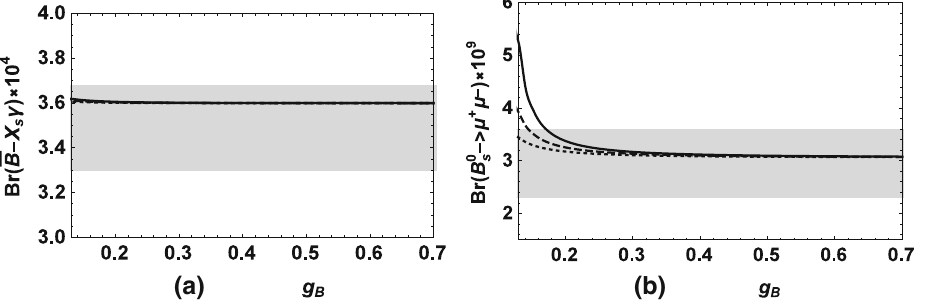
= − 0 . 6 ( solid line ), g for g B YB